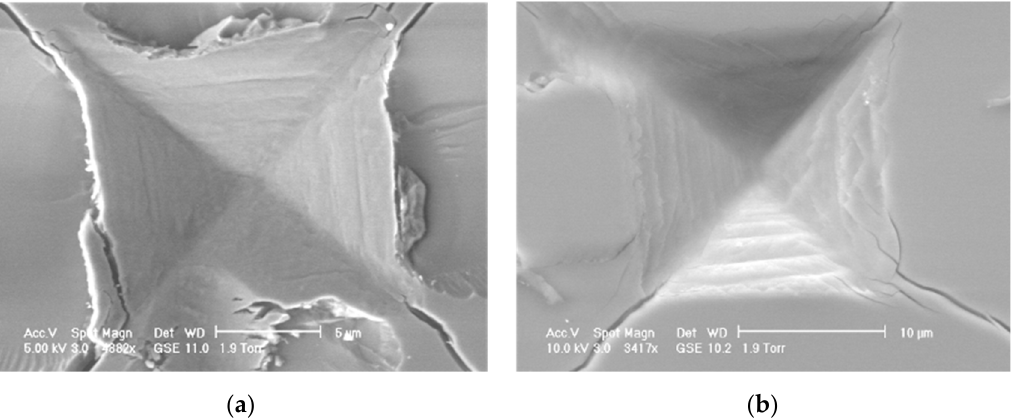
Figure 2. ( a ) 300 K Vickers indentation in Si(100) under a load of 2.63 N; the arrow highlights the extrusion. ( b ) 77 K Vickers indentation in Si(100) under a load of 5.21 N; the arrow points at a shear line.